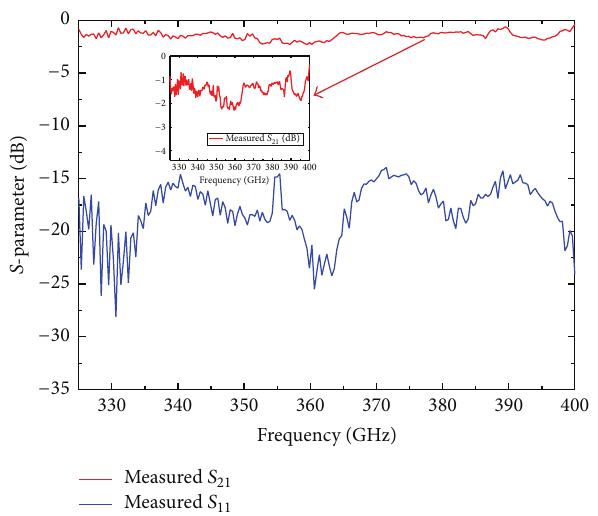
Figure 14: Measured results of the straight waveguide with length of 5.5 mm fabricated using the same DRIE process.